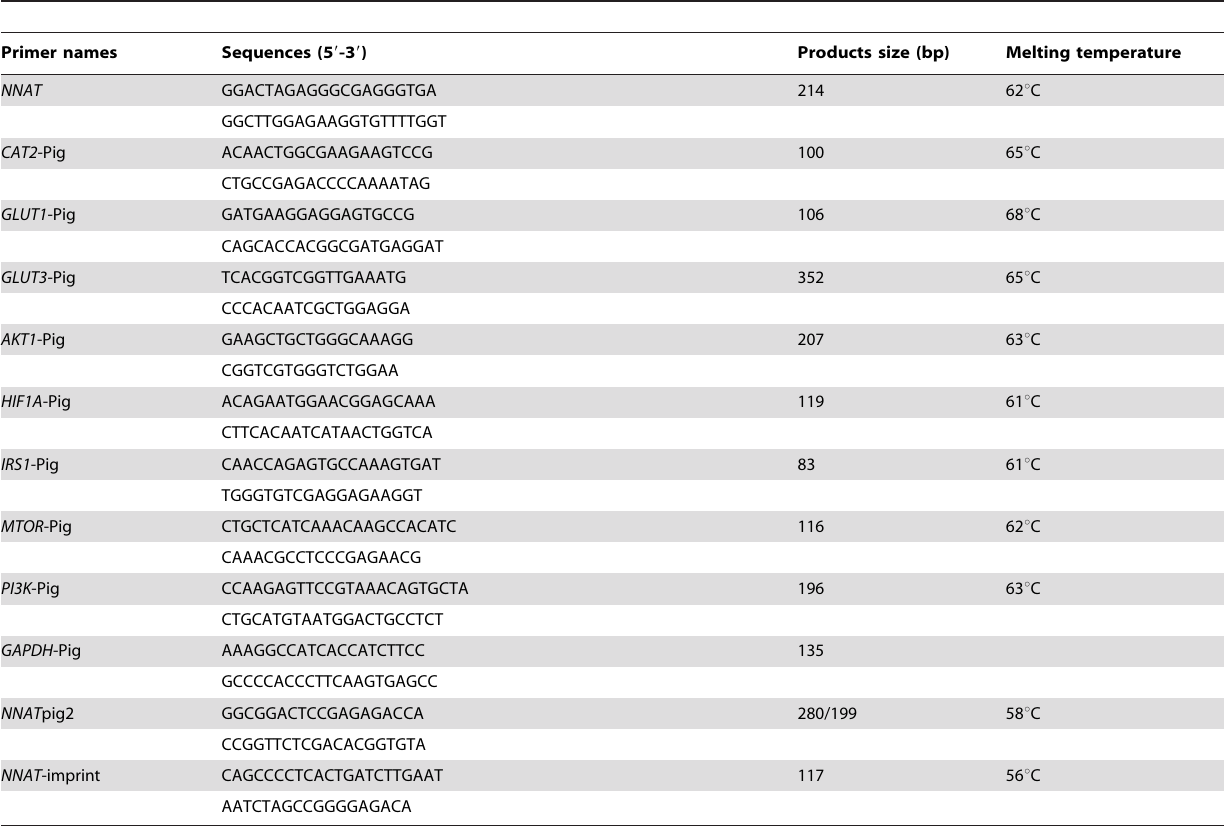
Table 2. Primers for NNAT and genes in pathway expression